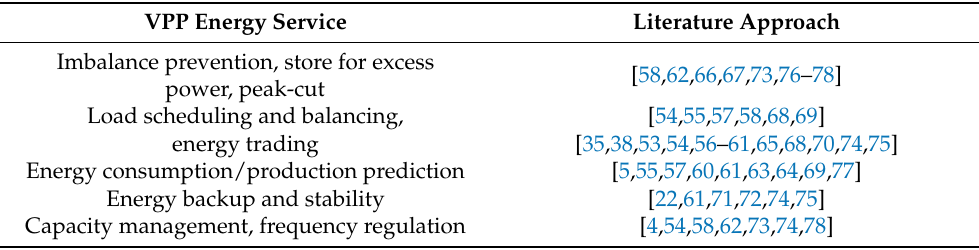
Table 3. Energy services delivery through VPP